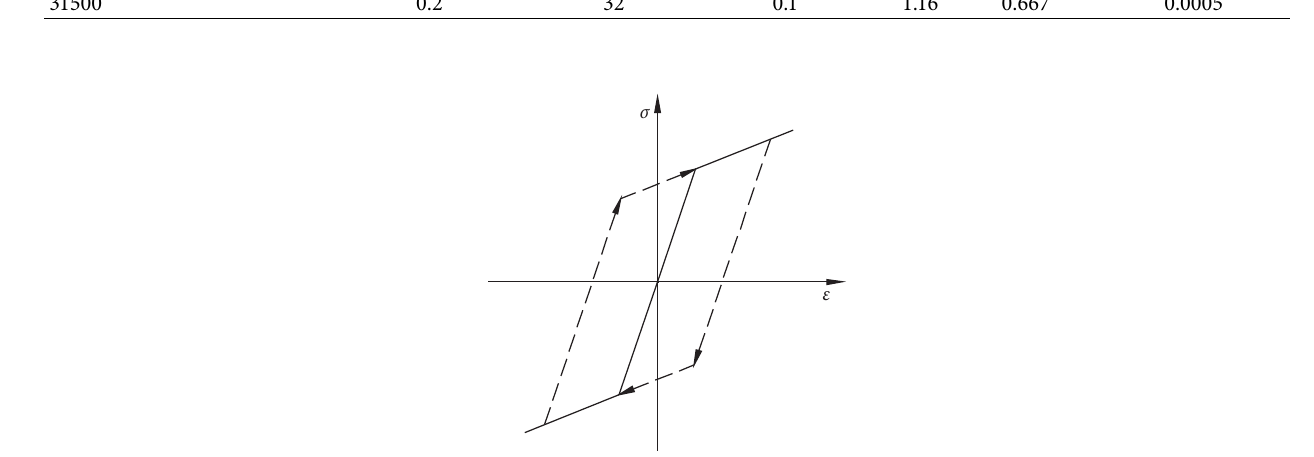
Figure 5: Dynamic hardening bilinear elastoplastic model.